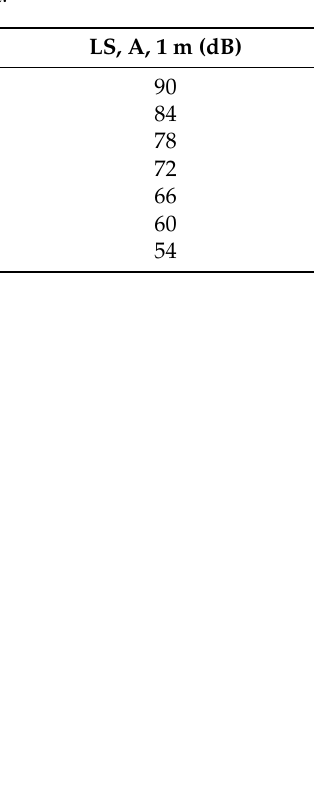
Table 8. Voice level according to the speaker’s vocal effort.